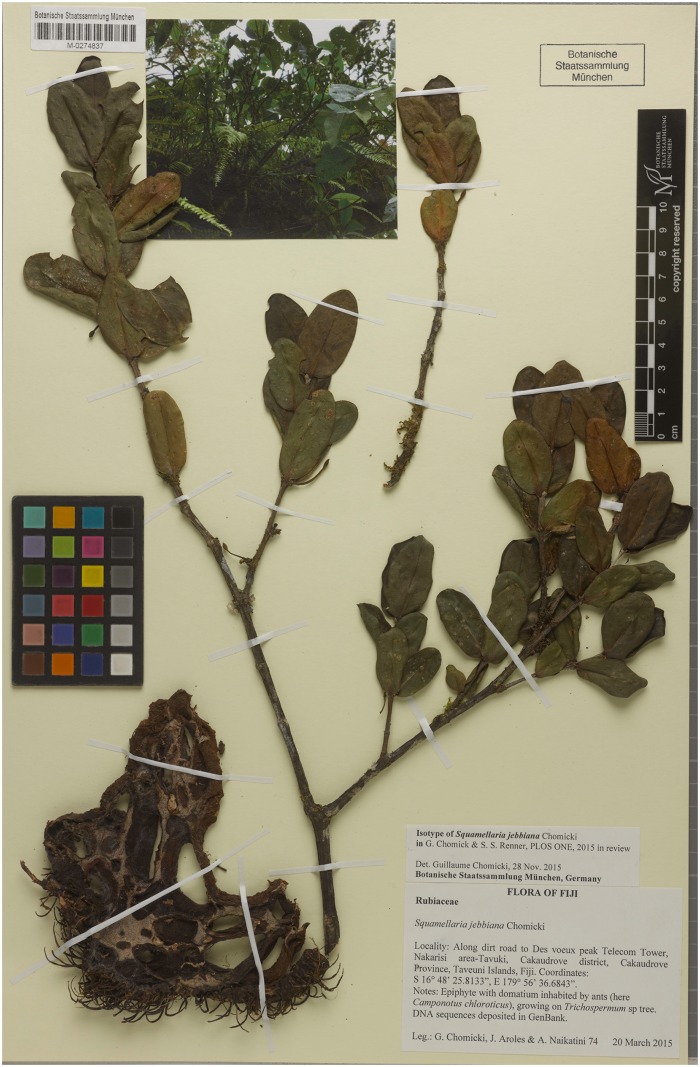
Isotype of Squamellaria jebbiana, G. Chomicki, J. Aroles, N. Naikatini 74 (M, barcode: M-0274837).